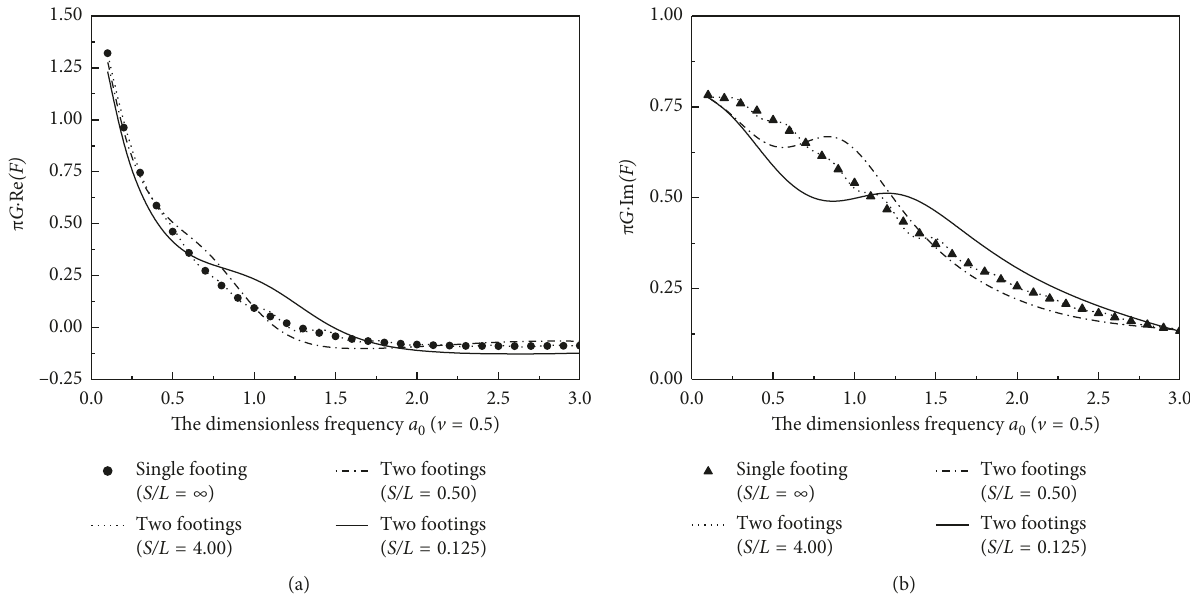
Figure 9: Vertical flexibility F ( a